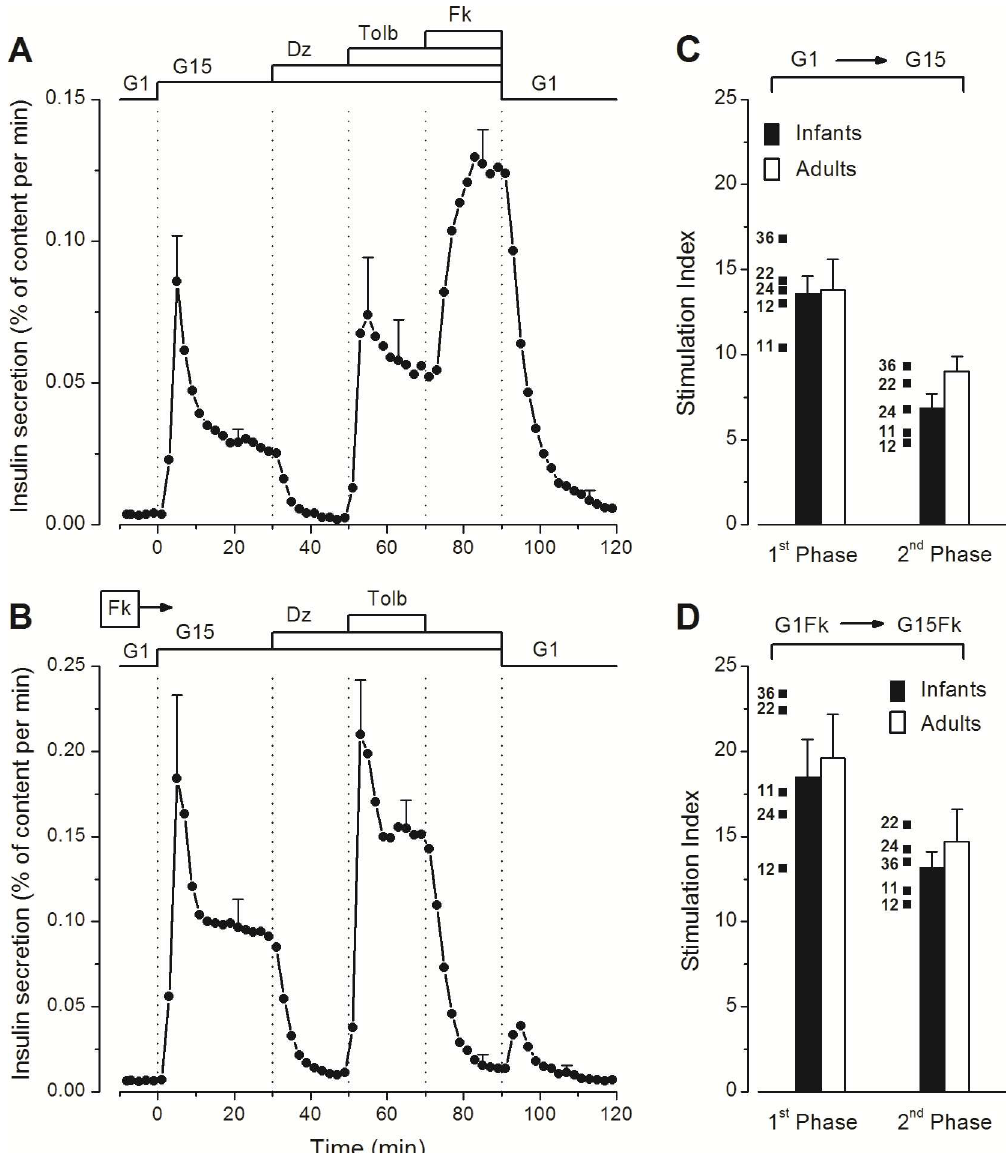
Fig 2. Dynamicsof glucose-induced insulin secretion in perifused islets from human infants. The experiments also tested the effects of drugs opening(diazoxide) or closing (tolbutamide) K ATP channelsand of an increase in islet cAMP by forskolin. (A) The concentration of glucose was changed between 1 and 15 mmol/l (G1, G15), and diazoxide(Dz, 100 μ mol/l), tolbutamide (Tolb, 100 μ mol/l), and forskolin (Fk, 1 μ mol/l) were added and withdrawn as indicated. (B) The whole experimentwas performed in the presence of 1 μ mol/l forskolin. Values are means ± SE for the five infant cases. (C and D) Glucose-induced insulin secretion was expressed as a stimulation index (ratio G15/G1) during first phase (2–10 min) and second phase (20–30 min) of the response. Mean and individual values for islets from the five infants (identifiedby age in months) are comparedwith mean values for 14– 16 islet preparations from normal adults